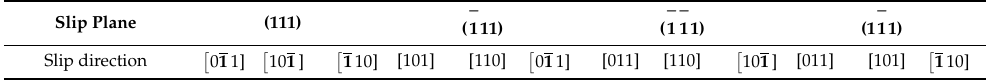
Table 1. Slip systems of Cu-8Al-11Mn alloy